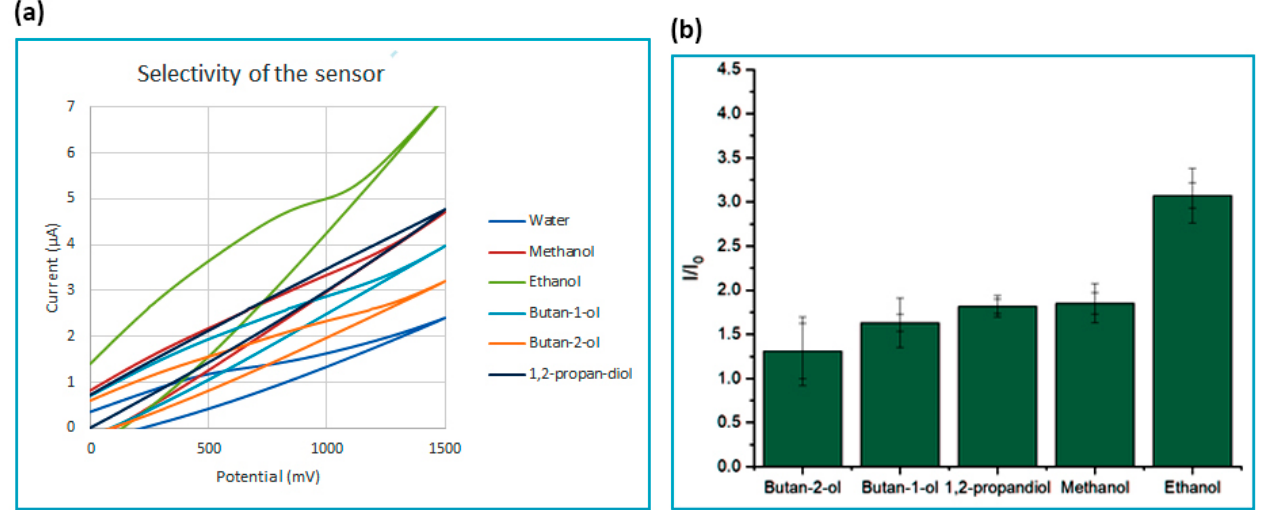
Figure 10. Response of the graphene–indium oxide sensor to various alcohols. While ( a ) shows only ethanol has an oxidation peak at the presence of the sensor, ( b ) measures the response in terms of numbers; I is the recorded current at the response potential of the sensor (0.5 mol/L concentration of different alcohols) and I 0 is the response of the sensor against blank (water) at the same study potential.